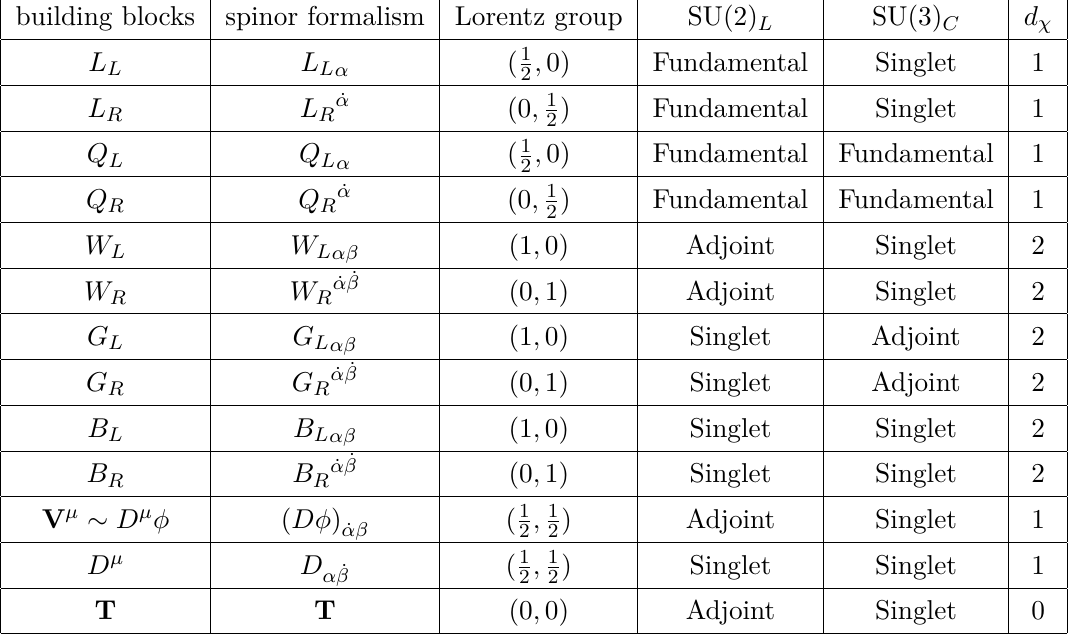
Table 2 . The building blocks of HEFT, their representation under the Lorentz and gauge groups, and the chiral dimension of them. To satisfy the Adler zero condition, we use D µ φ replacing V µ